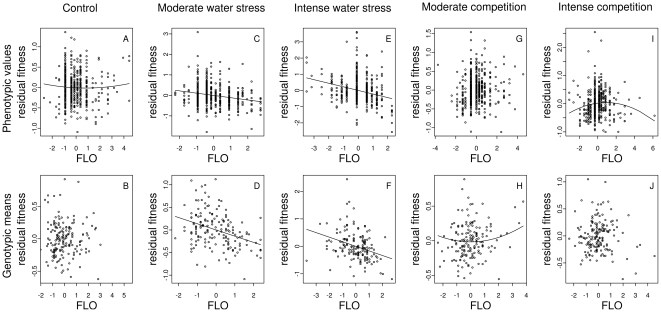
Relationship between flowering and fitness for each treatment at phenotypic and genotypic levels.For illustration purposes, a polynomial regression including both linear and quadratic terms described either in Table 1 (phenotypic level) or in Table 2 (genotypic level) was first performed including all traits but flowering duration. Then, a second polynomial regression including the linear and quadratic terms associated with flowering duration was run on the residual fitness of the first polynomial regression. The black lines were drawn using the parameters from this second polynomial regression. FLO: flowering. FLO is expressed in standardized values. The absence of a black line indicates that there is no significant linear or quadratic relationship between fitness and flowering (see Tables 1 and 2).